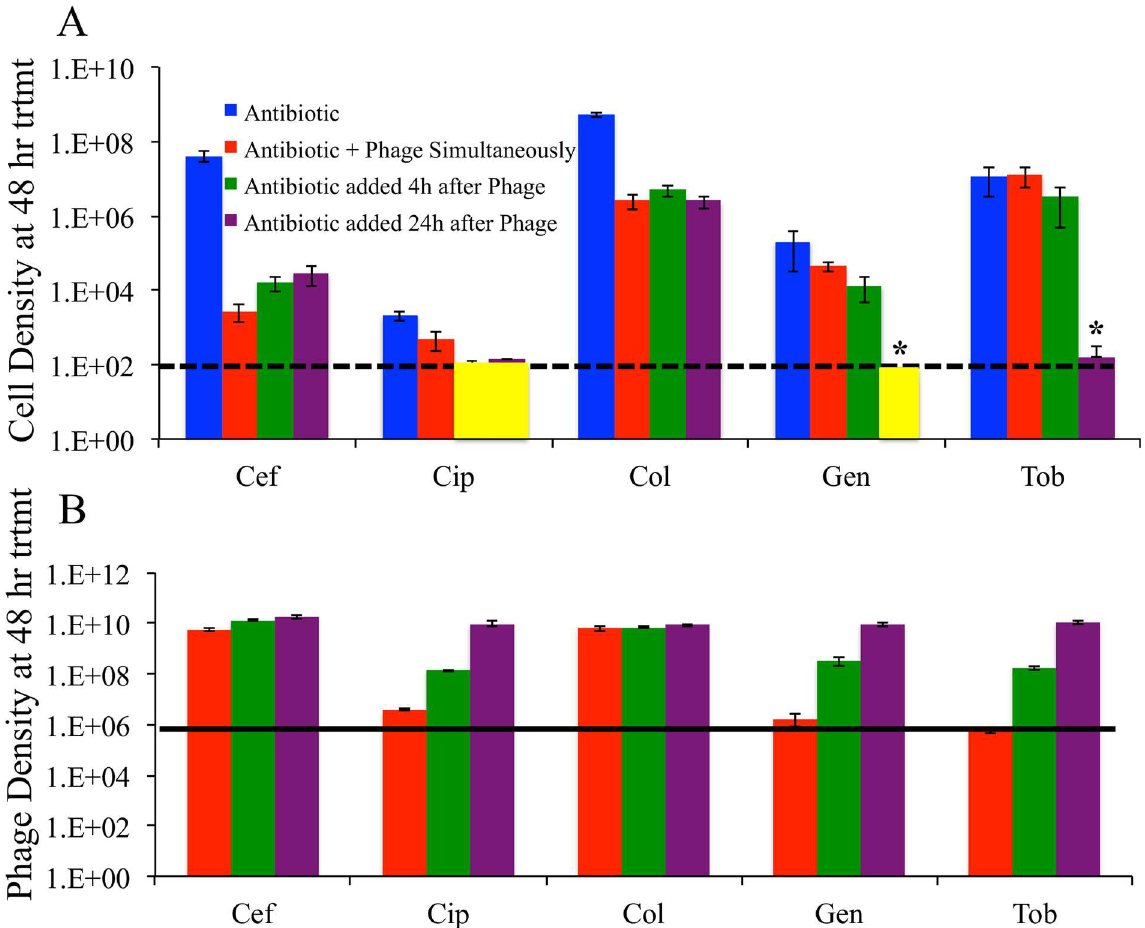
Fig 4. Effect of treatment order in killing P . aeruginosa PA14 on plastic. Bacteria alone were grown 48 hours, then treated with the two phages(N) for 0, 4 or 24 hours. They were then treated with the drug (8X MIC, abbreviationsas in Fig 3) for the durationof treatment. Starting from the time phages were added, the culture was grown 48 hours, so the durationof treatment followingantibiotic addition was shorter with the longerphage pretreatments. ( A) Densitiesof viable P . aeruginosa PA14 at the end of treatment. The horizontal dashed line is the limit of detection(10 2 /mL), and yellow boxes indicate that estimates were belowthe limit of detection. ( B) Densitiesof phage at the end of treatment. The bold black line in (B) is the initial density of phage introduced. * Indicatesthat the 24 hours delay of gentamycin and tobramycineach have statisticallysignificanteffects on cell density comparedto simultaneous treatment (P < 0.04, when correcting for multiplecomparisons; tests of significancewere equivalent for a Mann-Whitney U test and a mediantest using a Fisher’s exact test calculation—parametric tests were not possiblebecauseof some censoreddata). Means and standarderrors from data obtained from two independentexperiments, with a combinedtotal of 5 replicatecultures. Raw data of these experiments can be found in (S2 Excel